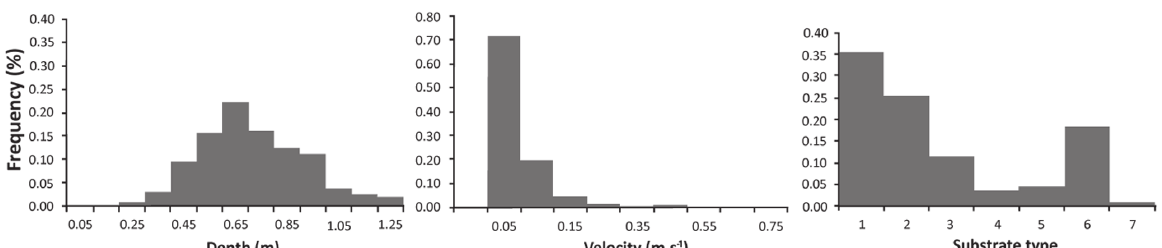
Fig. 3. Frequencies of habitat availability by classes of depth (m), mean velocity (m/s) and type of substrate (1- large boulder; 2- boulder; 3- cobble; 4- gravel; 5- fine gravel; 6- sand and 7- vegetation), obtained by direct survey in the riacho São Pedro.